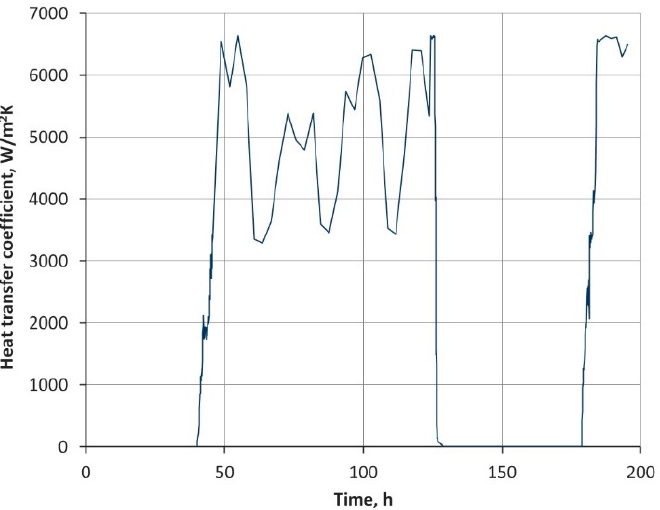
Figure 10. Values of the heat transfer coefficient as determined on the basis of the operating parameters of the pipeline based on the values of the characteristic numbers.